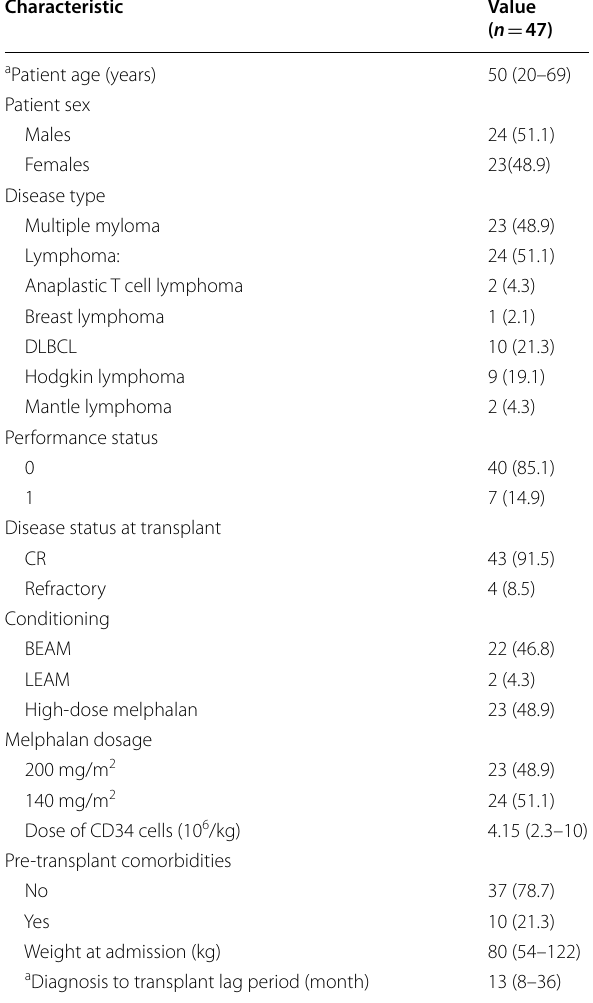
Table 1 Baseline characteristics of the